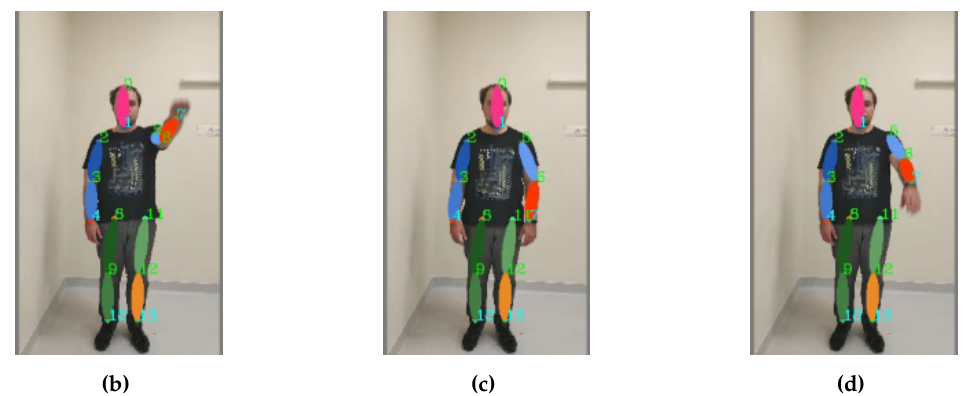
Figure 12. Footage of the exercise “Bend the Arm”: the motion sequence ( a – d ) starts on the left and ends on the right.